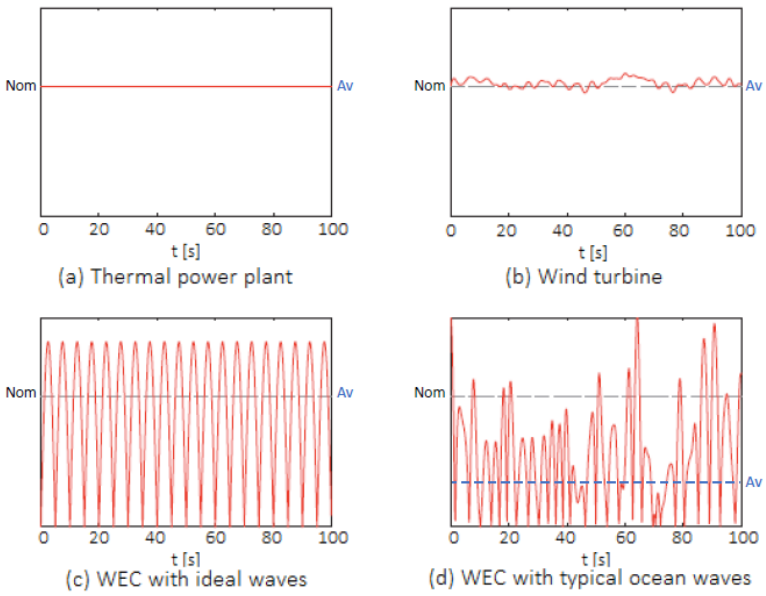
Figure 1. Power output signals from different sources: ( a ) conventional thermal plant, ( b ) wind turbine, and wave energy converter under unrealistic regular waves ( c ) and more realistic irregular waves ( d ), adapted from [1]. Nom refers to the nominal power specified by the rated generator capacity and Av refers to average power output.